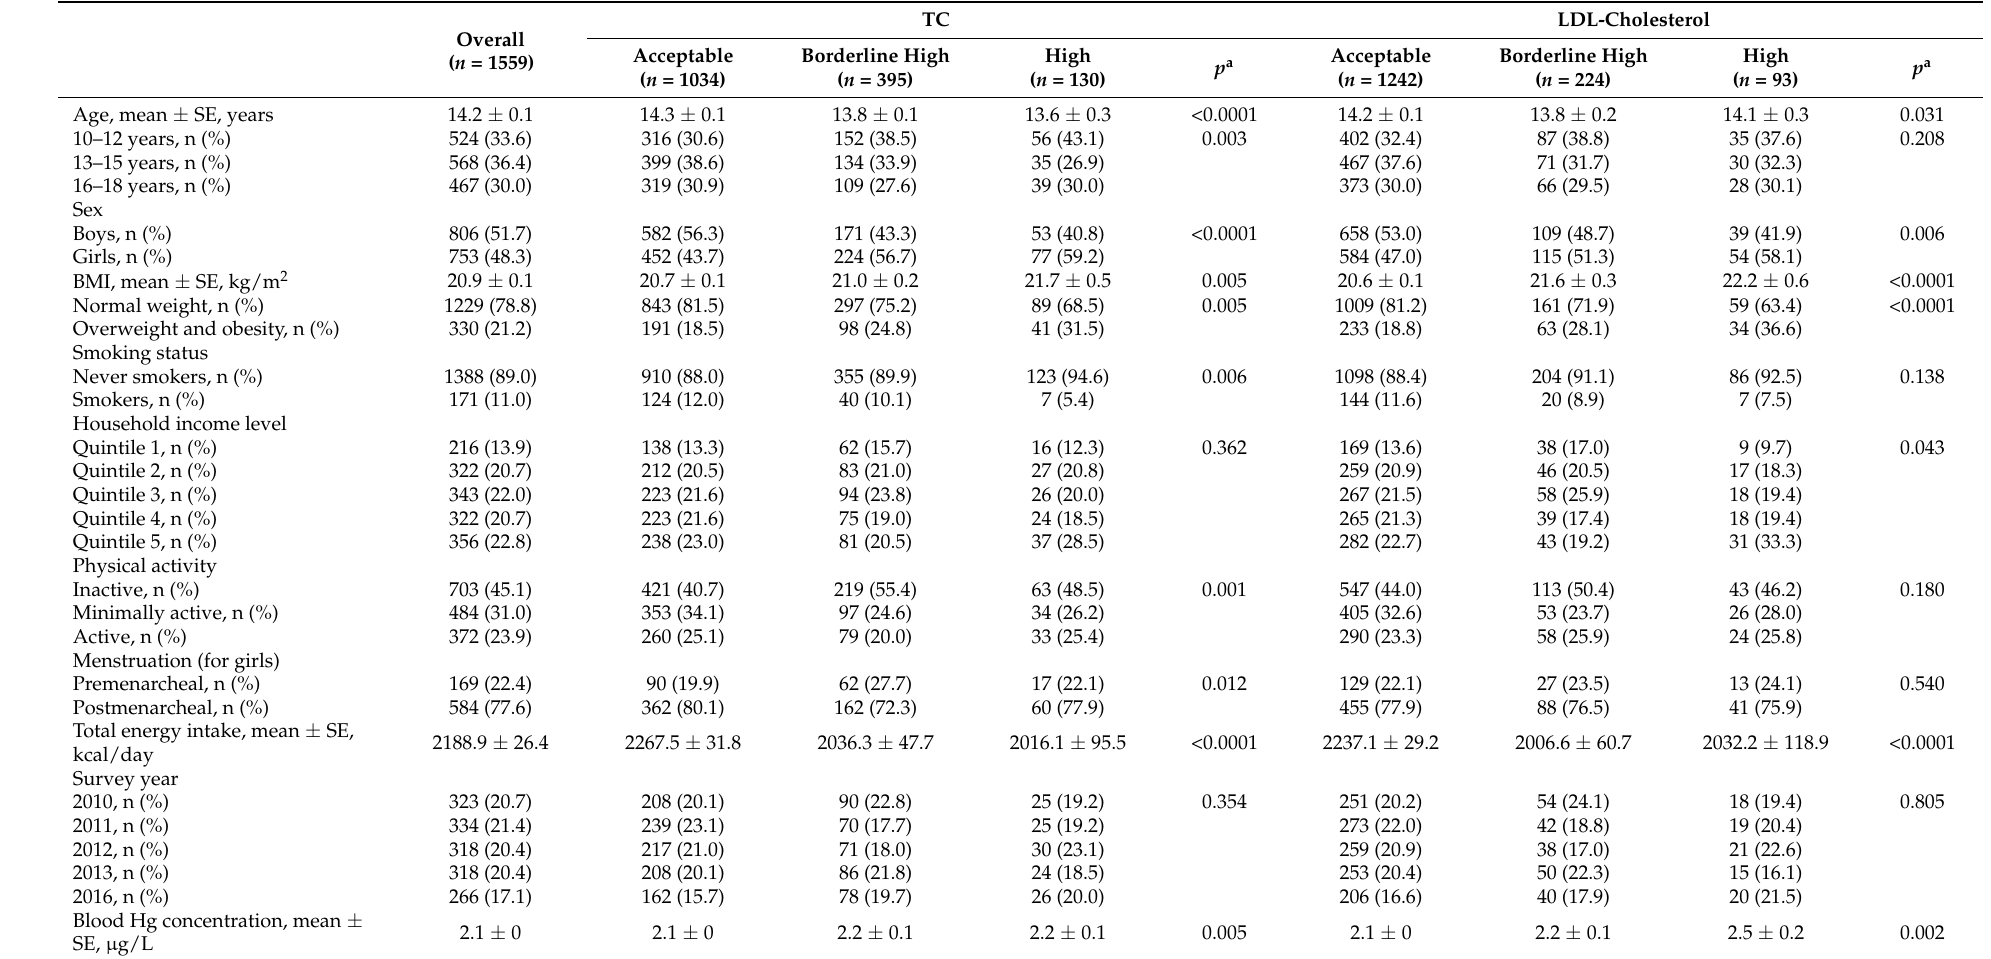
Table 1. Baseline characteristics of the study participants according to TC and LDL-cholesterol